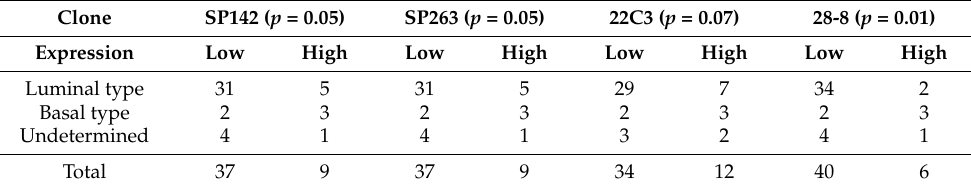
Figure 4. High PD-L1 expression demonstrated by the four clones in a case (marked by a circle on the TMA map). Table 3. Distribution of high PD-L1 expression cases among phenotypes.